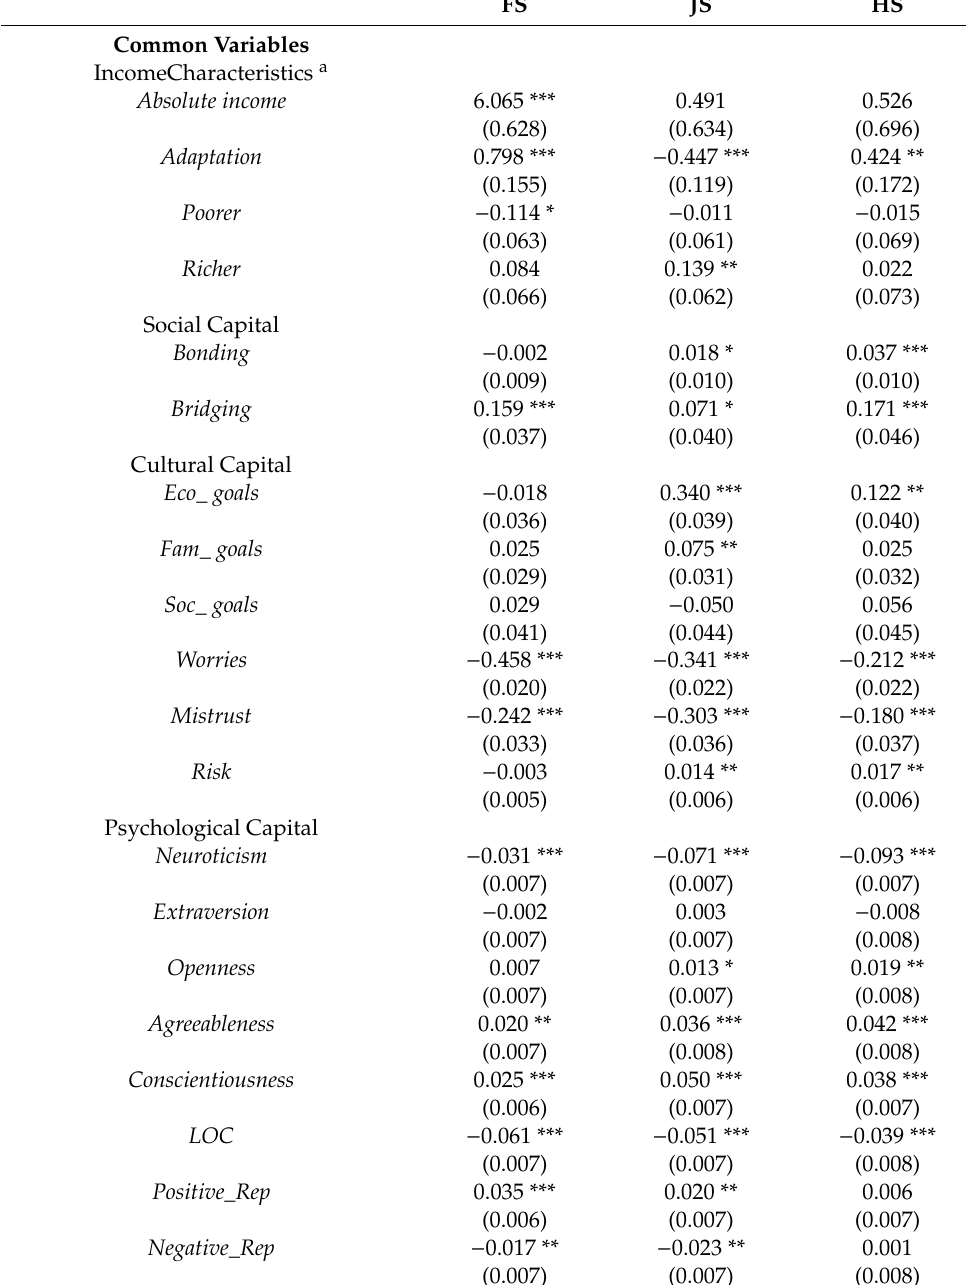
Table 3. Estimation results for domain satisfactions of German citizens,